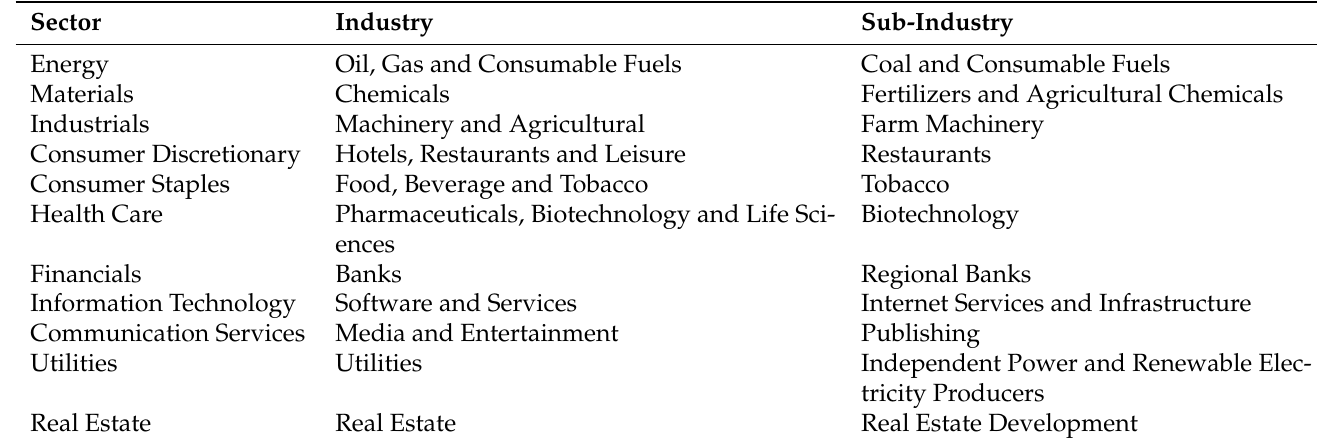
Table 2. Major sectors according to the taxonomy of the Global Industry Classification Standard (GICS) that categorizes the industry into 11 Sectors, 24 Industry groups, 69 Industries and 158 sub-industries; see